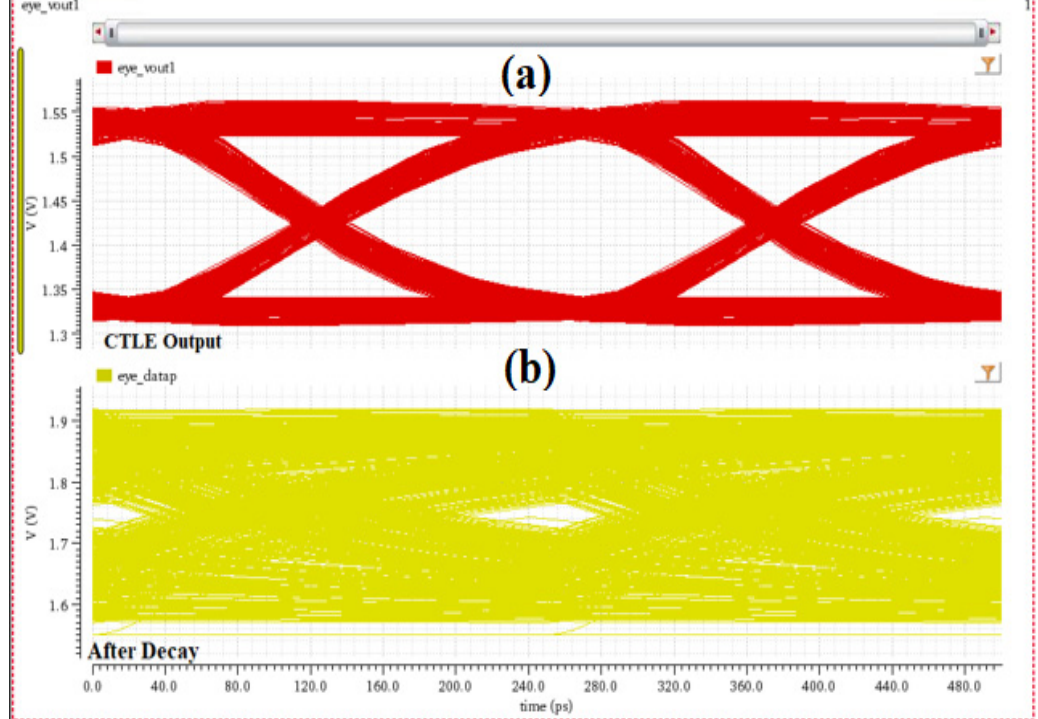
Figure 13. Simulated Output Eyes ( a ) with CTLE Enabled and ( b ) with CTLE Disabled.